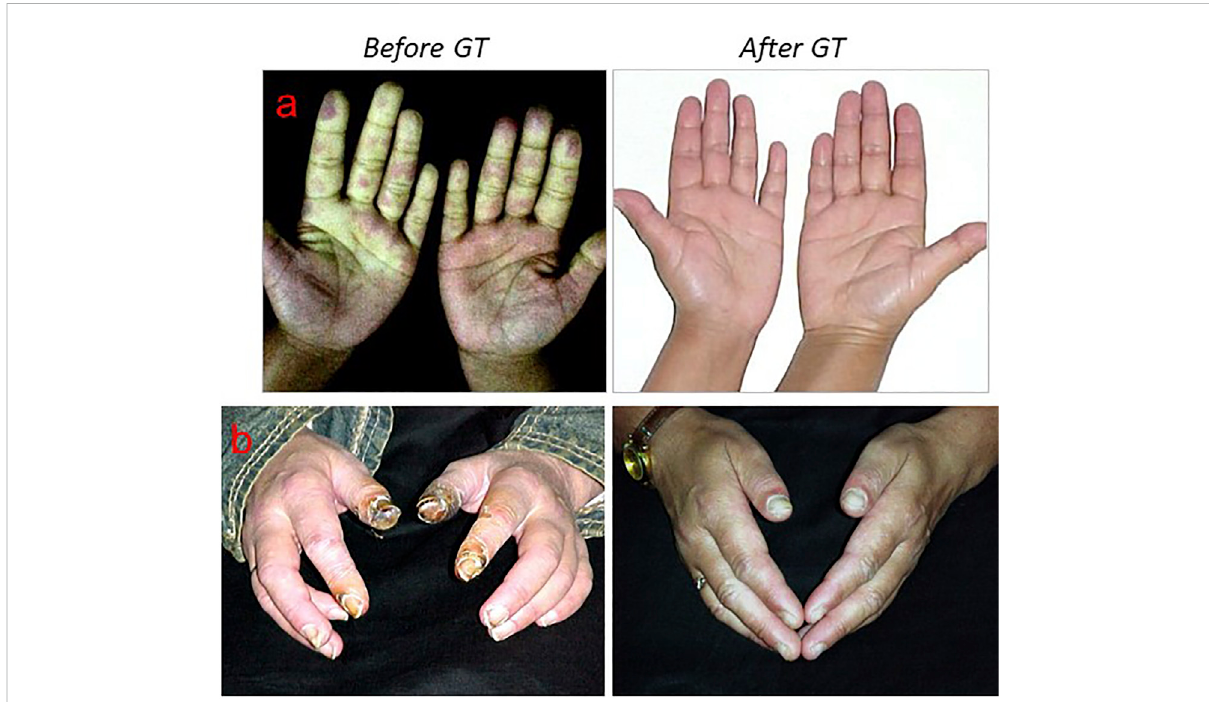
FIGURE 4 Two examples of patients with severe secondary Raynaud´s phenomenon treated with gravitational therapy. (A) A 36-year-old female patient with severe secondary Raynaud ’ s Phenomenon. Before treatment, severe vasoconstriction (pallor and cyanosis) and puffy fi ngers (left image).